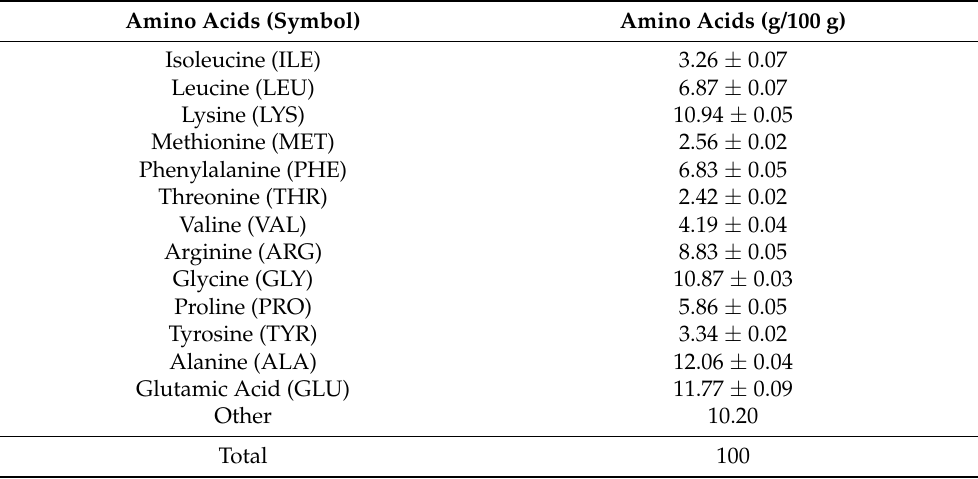
Table 1. Amino acid composition of the anchovy viscera protein hydrolysates analyzed by HPLC [24]. Amino Acids